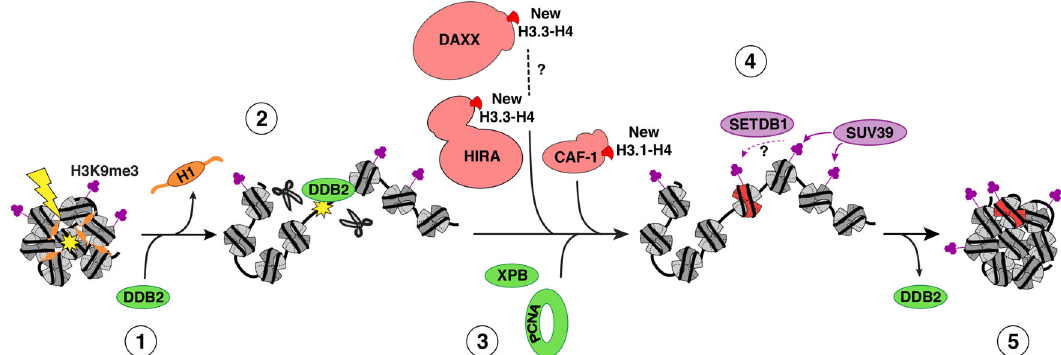
Fig. 7 Model for heterochromatin maintenance following UVC damage. Recognition of UVC damage by the sensor protein DDB2 (1) leads to linker histone H1 displacement and decompaction of damaged pericentric heterochromatin (2), thus facilitating access of downstream repair factors and histone chaperones (3) to the core of the domain. Histone chaperones promote the incorporation of newly synthesized H3 histones (in red), which subsequently acquire heterochromatin-speci fi c modi fi cations through the action of histone methyltransferases (4). DDB2 release during repair progression allows heterochromatin